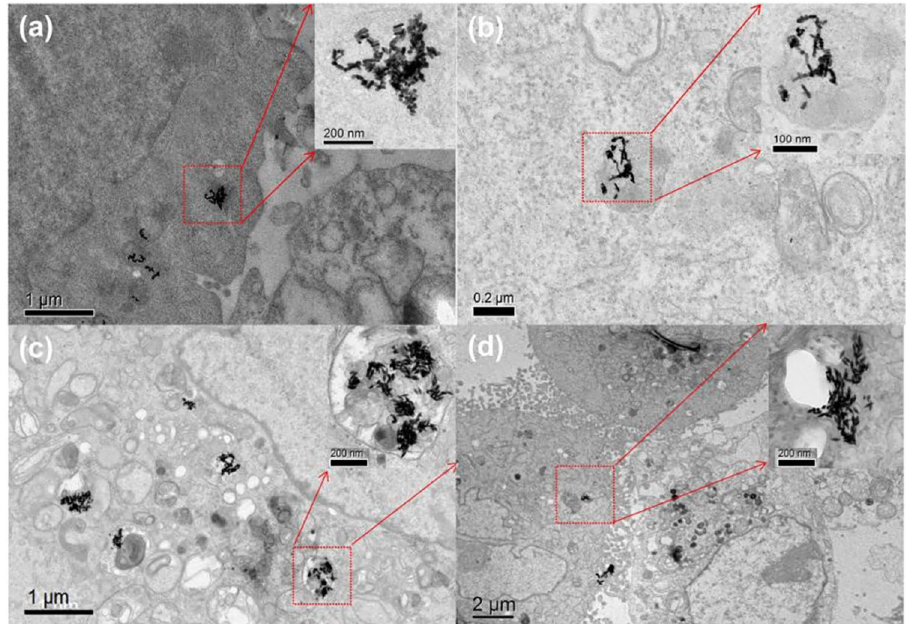
Figure 2. ( a – d ) TEM images of HepG2 cells incubated with GNPs for 24 h. ( a , b ) TEM images of cells after taking GNRs with an AR of 3.50 and 3.71 respectively; ( c,d ) TEM images of cells after taking GNBs with an AR of 2.92 and 3.03